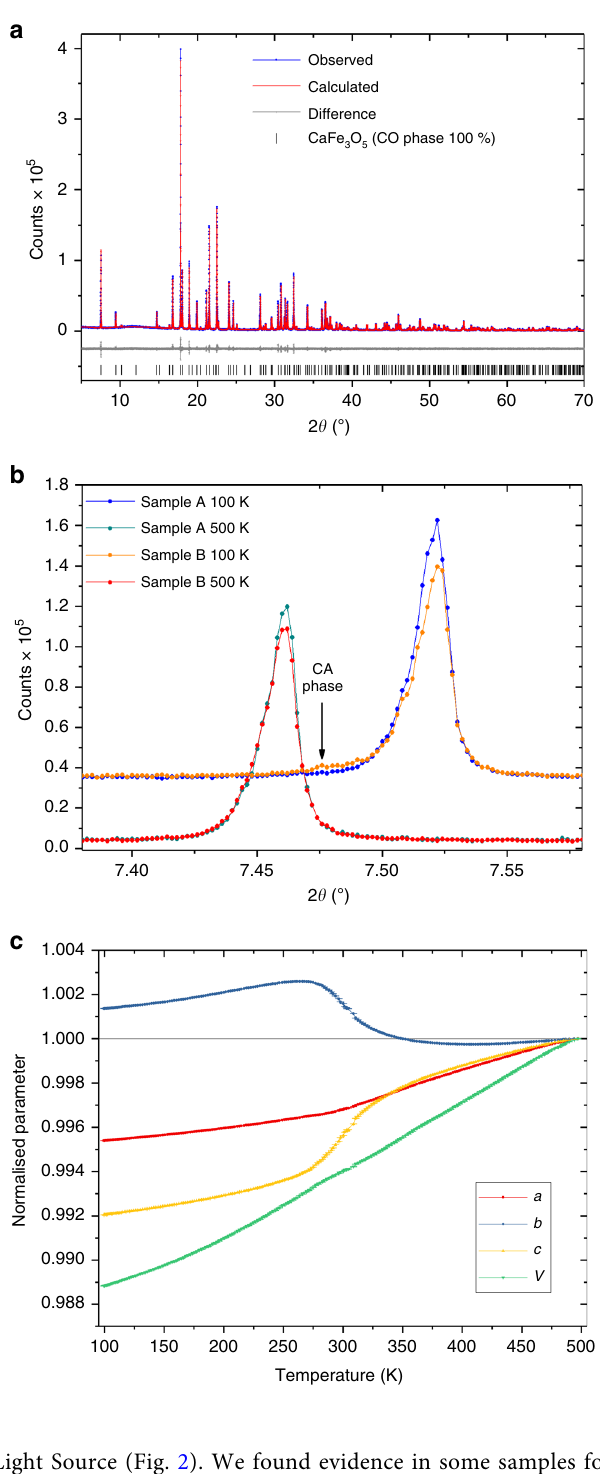
Hong et al. 13 but of fi ve samples measured, the maximum amount of the CA phase at 100 K was estimated to be 2.7% (in sample B); much lower than the ~40% reported in the sample of Hong et al. 13 . In three samples, including the sample mea- sured by neutron diffraction (sample A) there was no detect- able CA phase in the PXRD, showing that the synthesis route reported here (which differs from that of Hong et al. 13 ) reliably produces samples which yield only the CO phase at low temperatures.